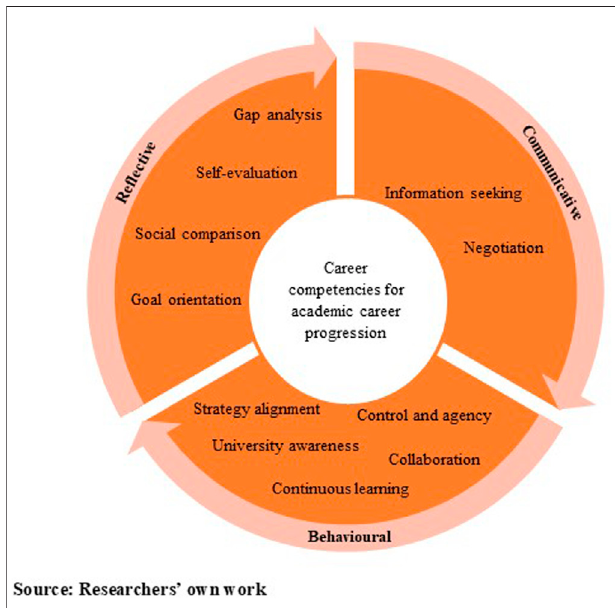
FIGURE 1 | Career management competencies of academics structured within the three competency